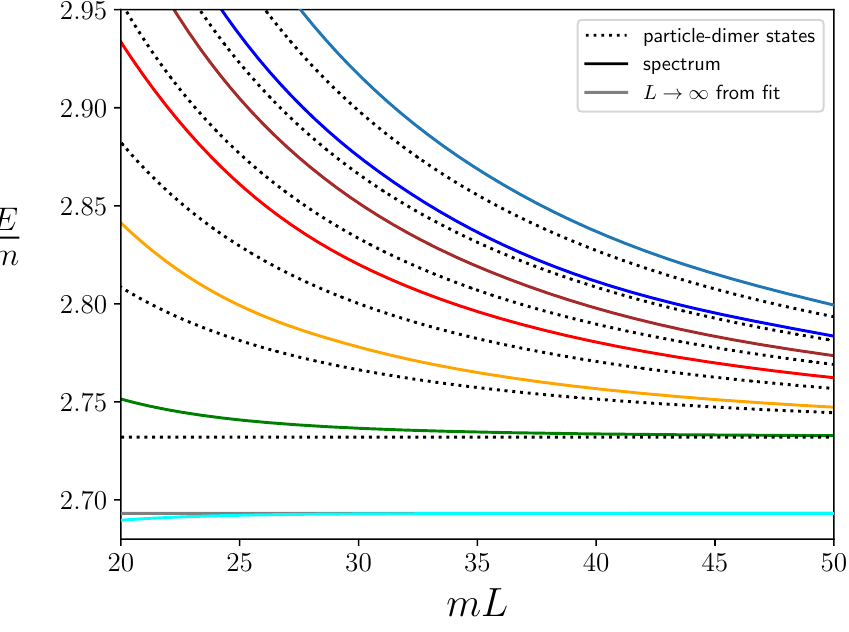
Figure 5 . Low-lying spectrum for ma 0 = 2 and K iso = 0 for larger mL . This is the continuation df ; 3 to larger volumes of the spectrum shown in the bottom right-hand panel of (cid:12)gure 4. Note the highly compressed vertical scale. The horizontal line for the lowest level gives the L ! 1 asymptote for the trimer energy, using a (cid:12)t described in the